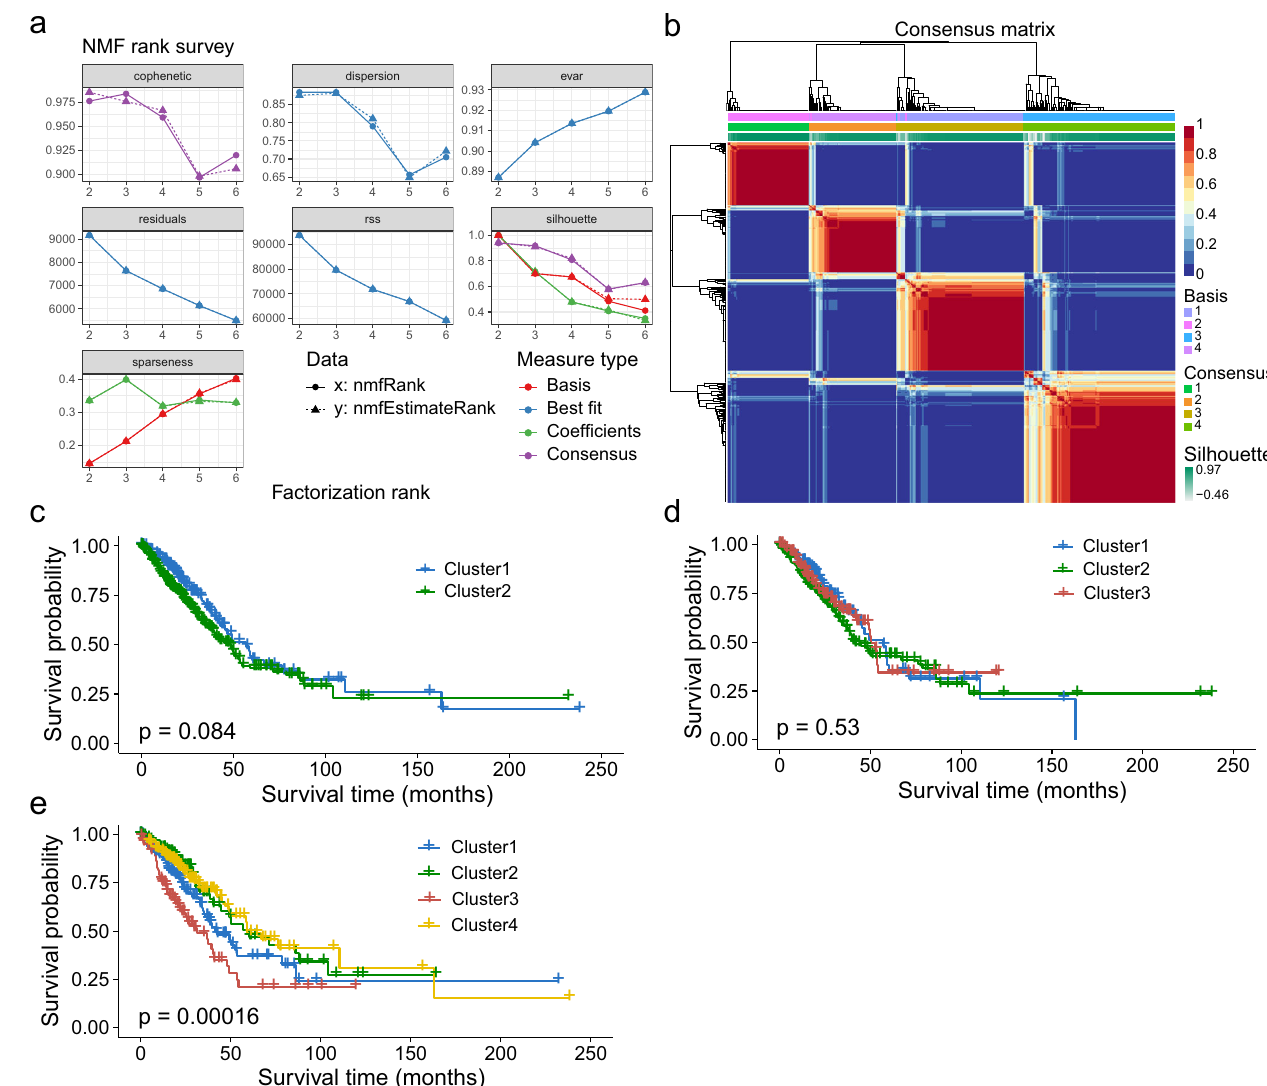
Fig. 2 Subtypes strati fi cation and survival analysis on different numbers of clusters. a According to the cophenetic parameters of NMF, TCGA-LUAD samples were divided into four subtypes. The line x (solid line) was drawn according to the nmf function. The line y (dotted line) was set according to the nmfEstimateRank function. These results were plotted to choose the optimal rank value. And, the x-axis value is the possible factorization rank (2 – 6), and the y-axis represents the cophenetic value. b Consensus map of NMF clustering results in TCGA-LUAD cohort. c , d and e The OS of patients with the 2, 3 and 4 subtypes were determined by Kaplan – Meier survival analysis, respectively. The P- values were calculated by the Log-rank